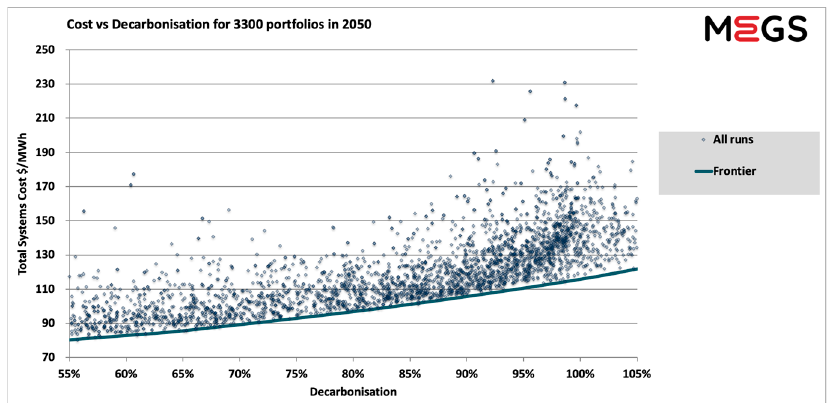
Figure 1. MEGS Cost vs. Decarbonisation for 3300 Scenarios.